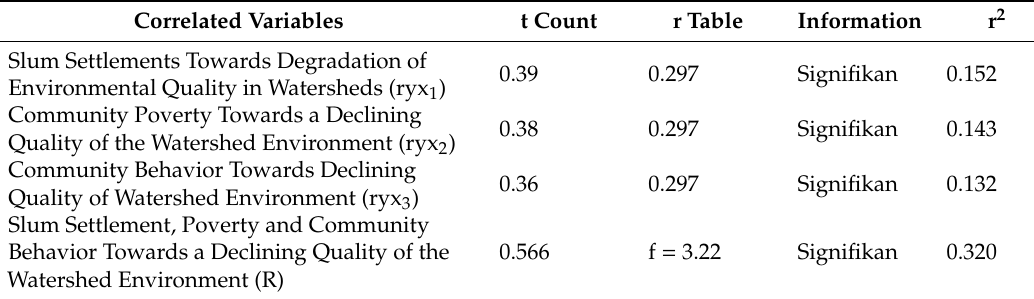
Table 2. Summary of Results of Associative Hypothesis Testing. Correlated Variables t Count r Table Information r